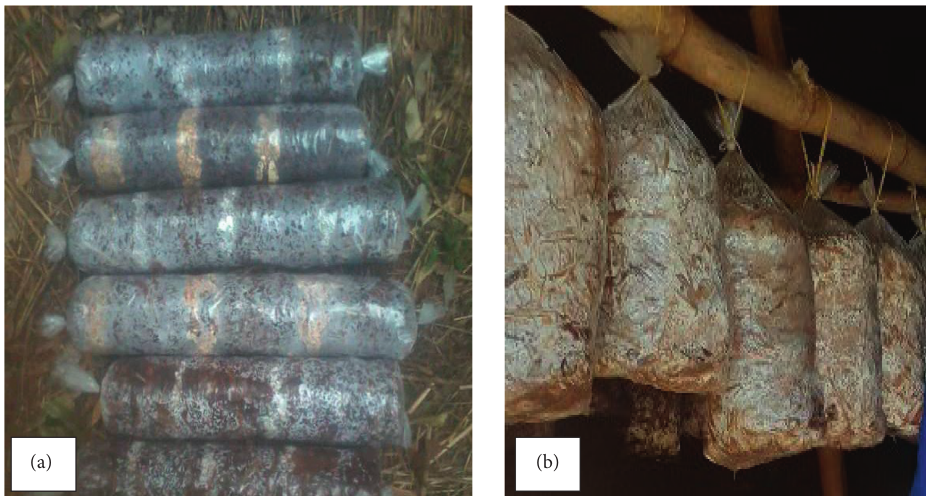
Figure 1: Pictures showing the bags soon after spawning and after full spawn run, respectively (from left to right).